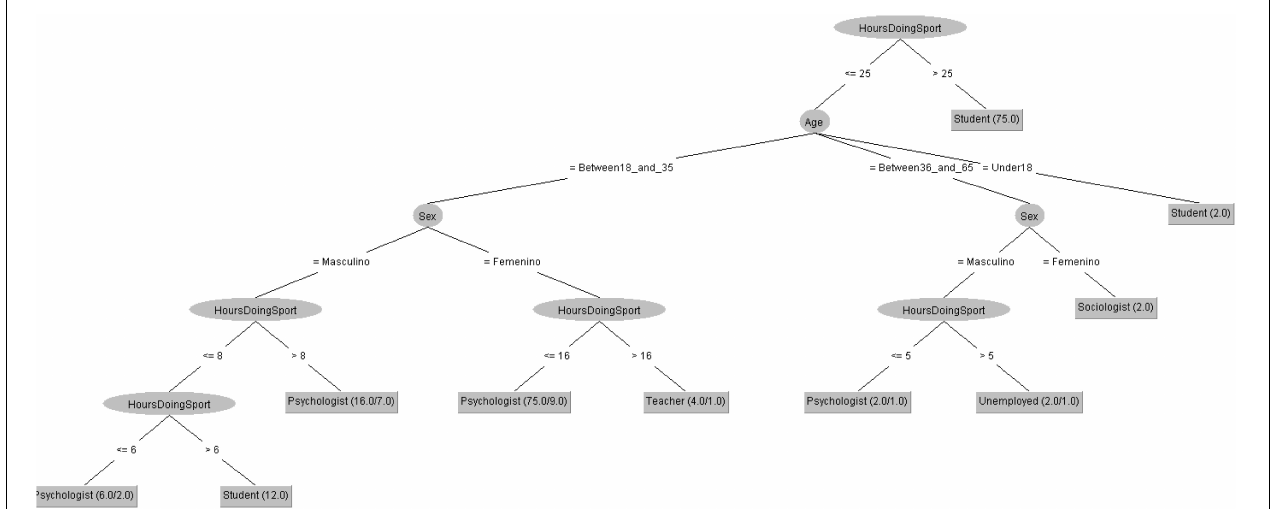
FIGURE 16 | Profession of people taking the MBI questionnaire in 2020 decision tree.